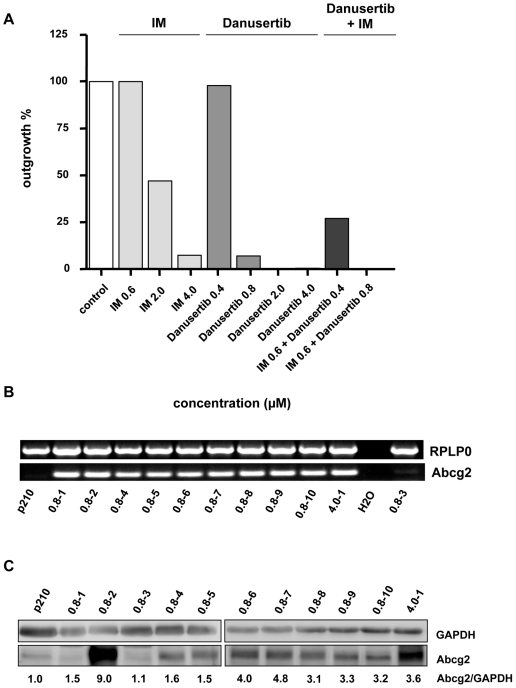
A–B: Danusertib induced Abcg2 overexpression in resistant clones and combination of Danusertib with IM reduces the frequency of resistant clones.(A) Ba/F3-p210 cells were cultured with graded concentrations of Danusertib or IM alone and in combination. Bars represent the percentage of wells from which drug-resistant clones were recovered. A total of 96 wells were analyzed in all experiments except those involving 0.8, 2, and 4 µM Danusertib as a single drug for which 144 wells were examined. (B) Abcg2 is overexpressed in all but one Danusertib-resistant clones. Semi-quantitative RT-PCR analysis for Abcg2 mRNA level in Danusertib-resistant clones and parental Ba/F3-p210 cells. (C) Abcg2 is overexpressed in all but two Danusertib-resistant clones. Western blotting analysis for Abcg2 level in Danusertib-resistant clones and parental Ba/F3-p210 cells. The relative expressions in comparison to GAPDH are indicated.